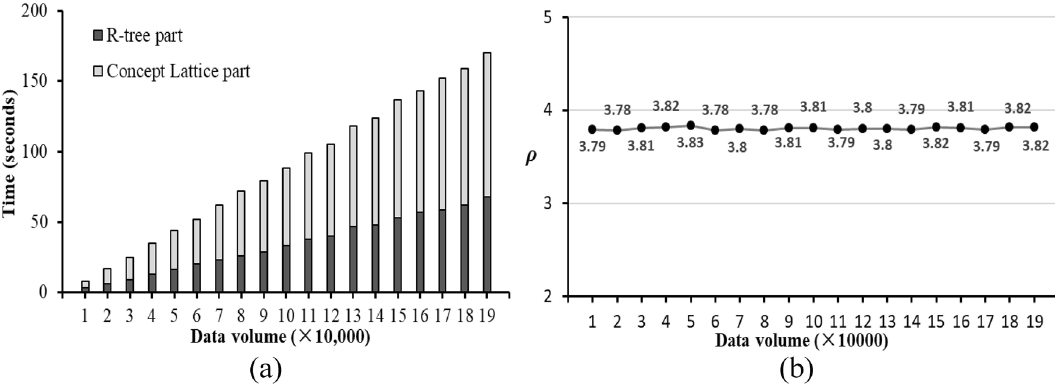
Figure 5. The influences of data volume on L Yelp . ( a ) The initialization time of L Yelp with different data volume, ( b ) The size ratio of ρ Yelp with different data